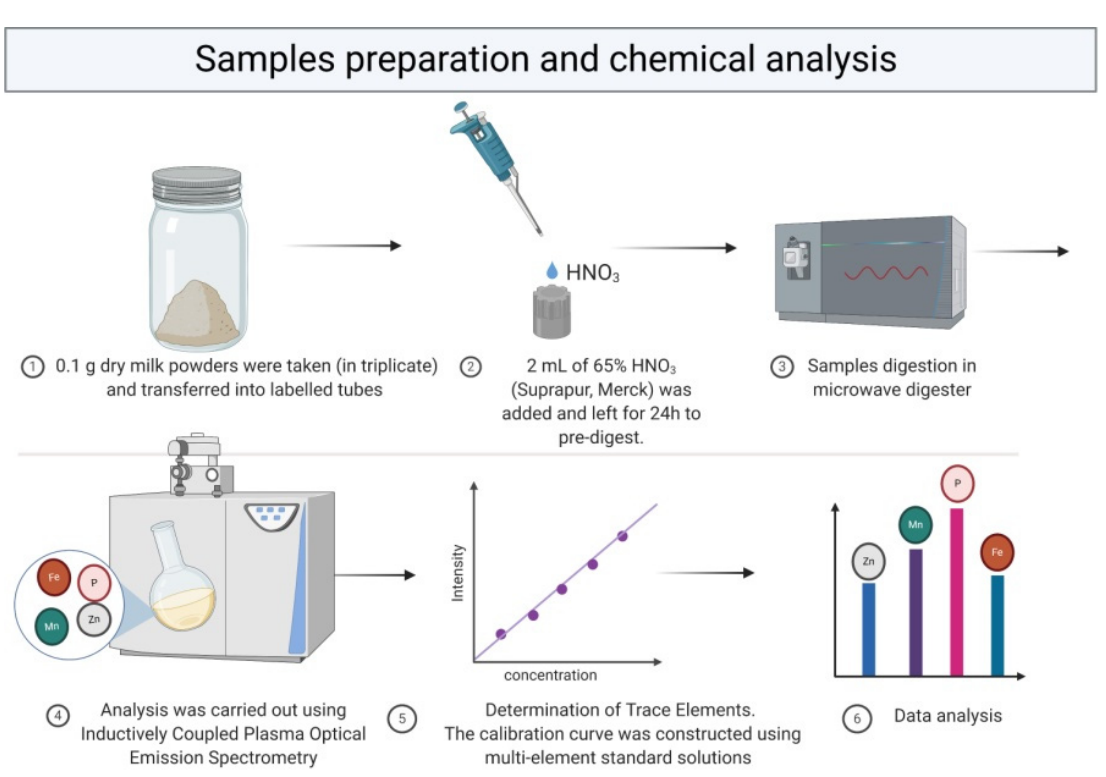
Figure 5. The workflow of samples preparation and chemical analysis (Created with BioRender.com).